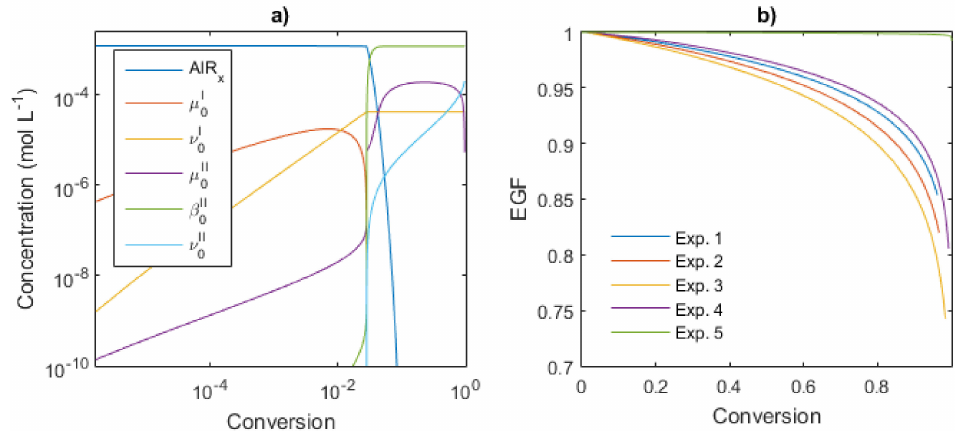
Figure 13. Analysis of the Kinetic behavior for the Exp 1: ( a ) Concentration profiles versus conversion, ( b ) EGF versus conversion. Operating conditions and initial concentrations are given in Table